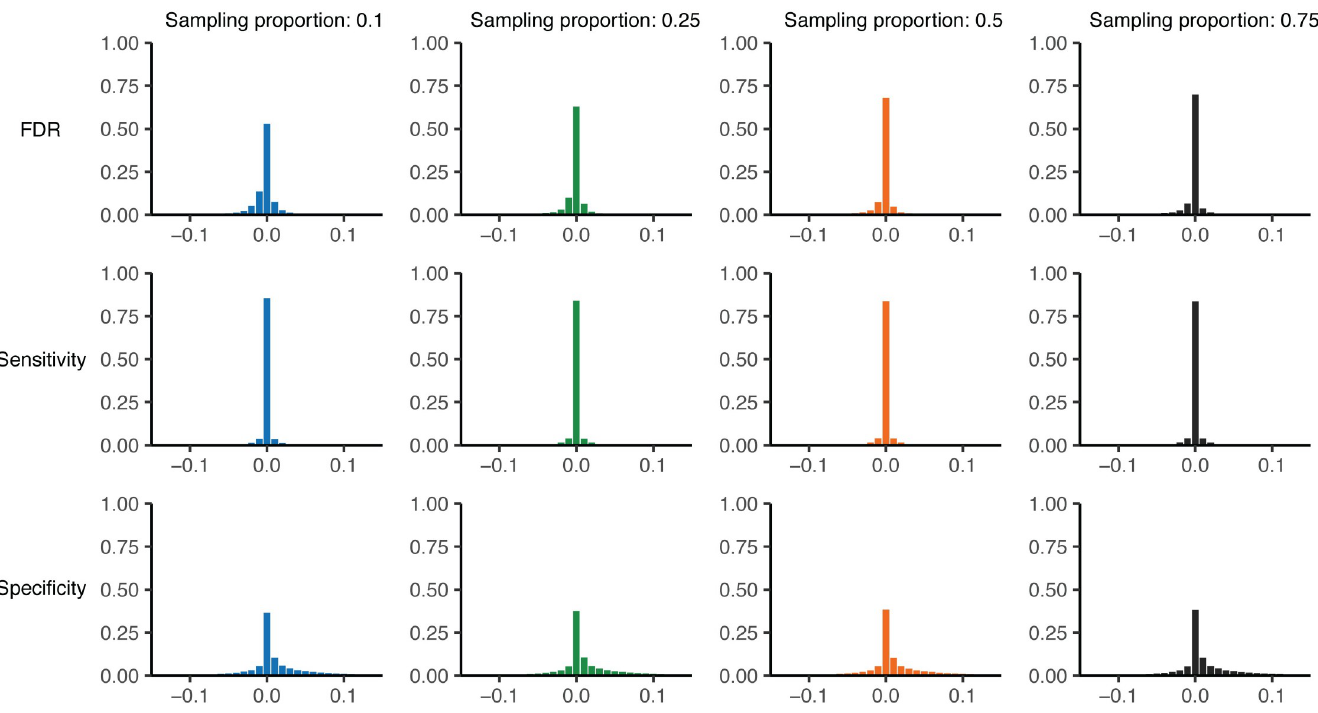
Fig 5. Histogram of raw parameter error using substitution rate method. Theoretical minus simulated parameter values for each genetic distance threshold in 10,000 simulations of varying substitution rate and reproductive number for a given sampling proportion (see Fig 4 ). Top row: theoretical minus simulated false discovery rate; middle row: theoretical minus simulated sensitivity; bottom row: theoretical minus simulated specificity. Colors correspond to sampling proportion as in Fig 4 .